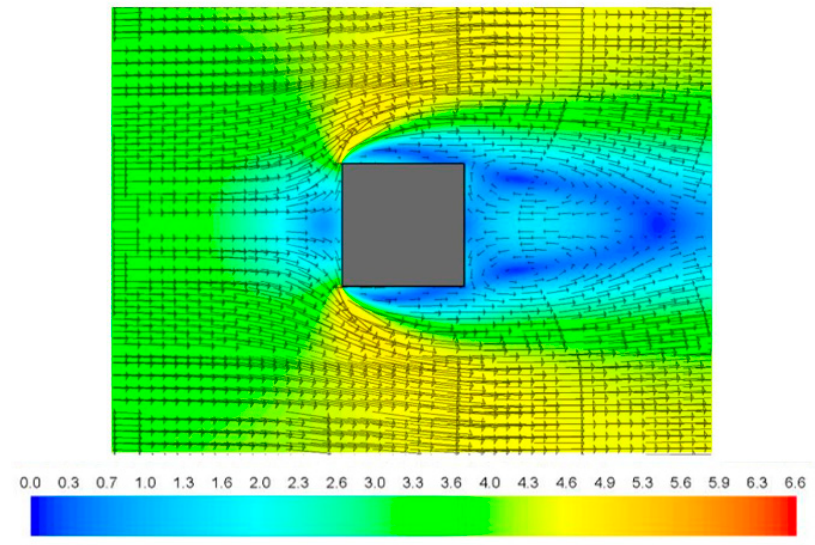
Figure 6. Pressure bubble formation, air velocity (m/s) and displacement vectors.